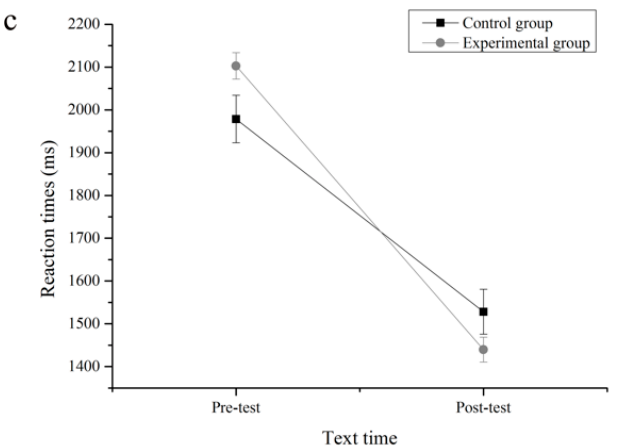
Figure 3. ( a ) Interaction of group (control group, experimental group) and test time (pre-test, post-test) in the percentage of hits. ( b ) Interaction of group (control group, experimental group) and test time (pre-test, post-test) in the percentage of false alarms. ( c ) Interaction of group (control group, experimental group) and test time (pre-test, post-test) in reaction times. Data are mean ± standard error (SE).